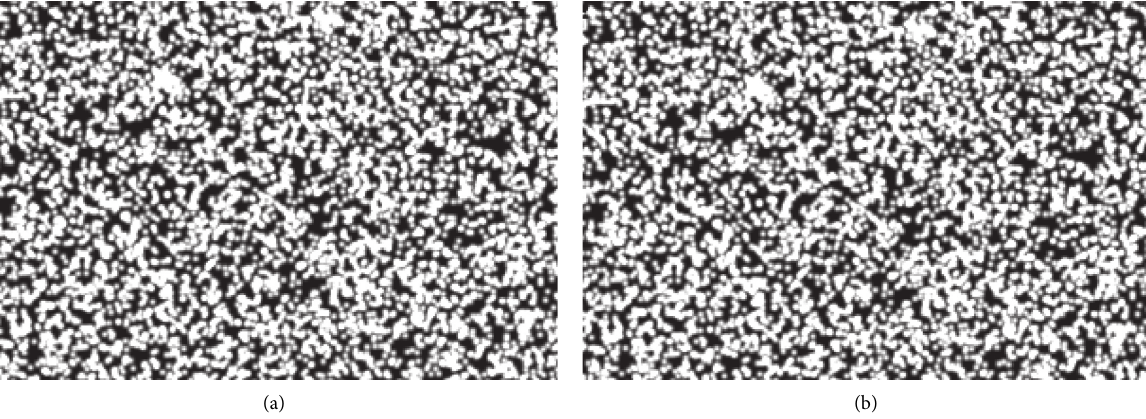
Figure 5: Values of η η / Q . 66 b 66 b